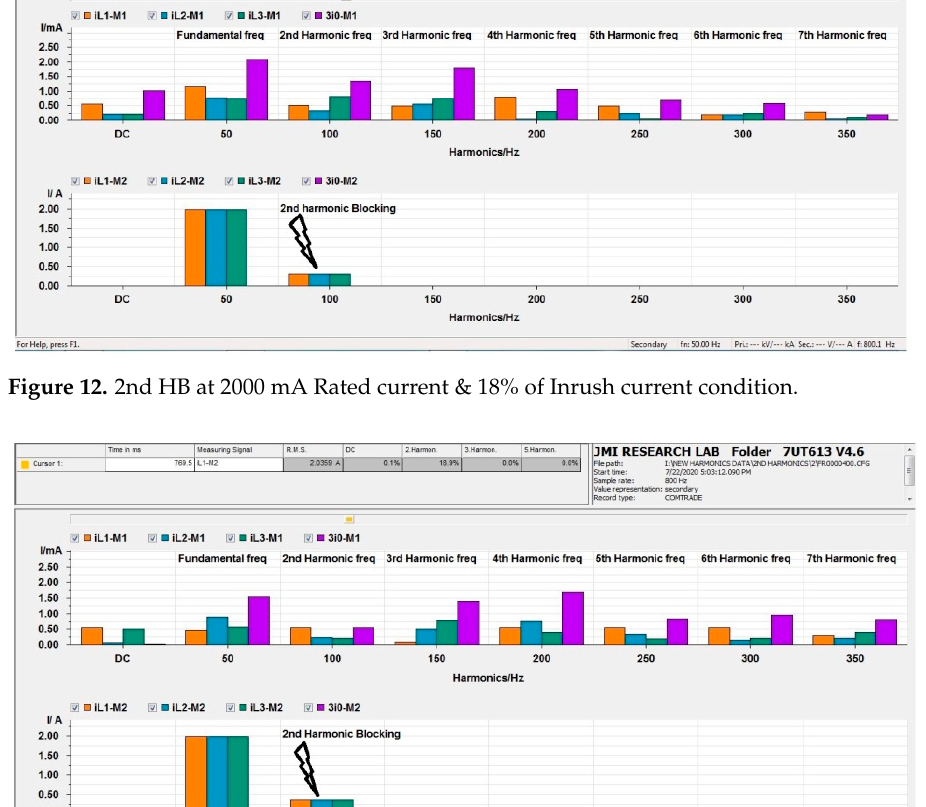
Figure 13. 2nd HB at 2000 mA Rated current & 20% of Inrush current condition.